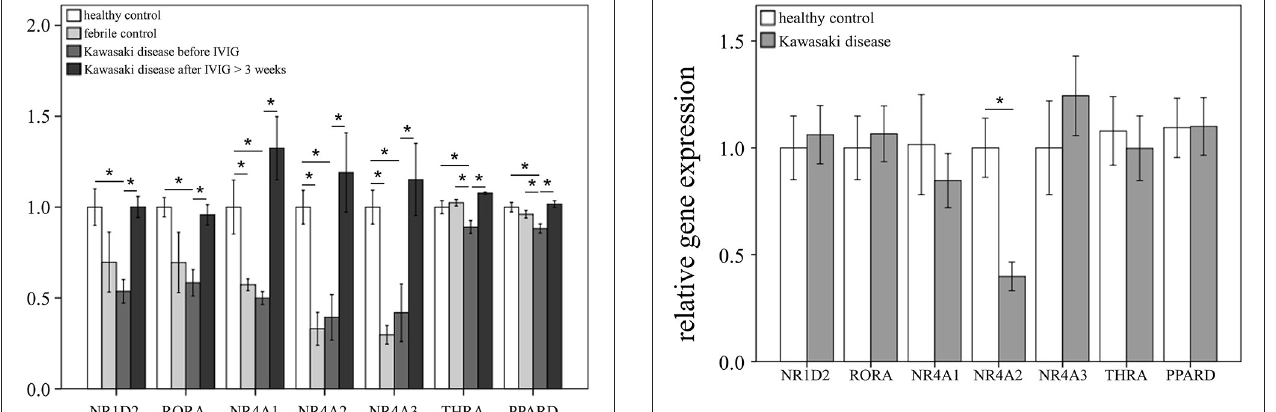
FIGURE 2 | Analyses of mRNA expression of steroid hormone receptors in the peripheral white blood cells of 48 patients with KD and 48 healthy controls using qRT-PCR. Data are expressed as mean ± standard error. *Significance ( p < 0.05) between the groups.